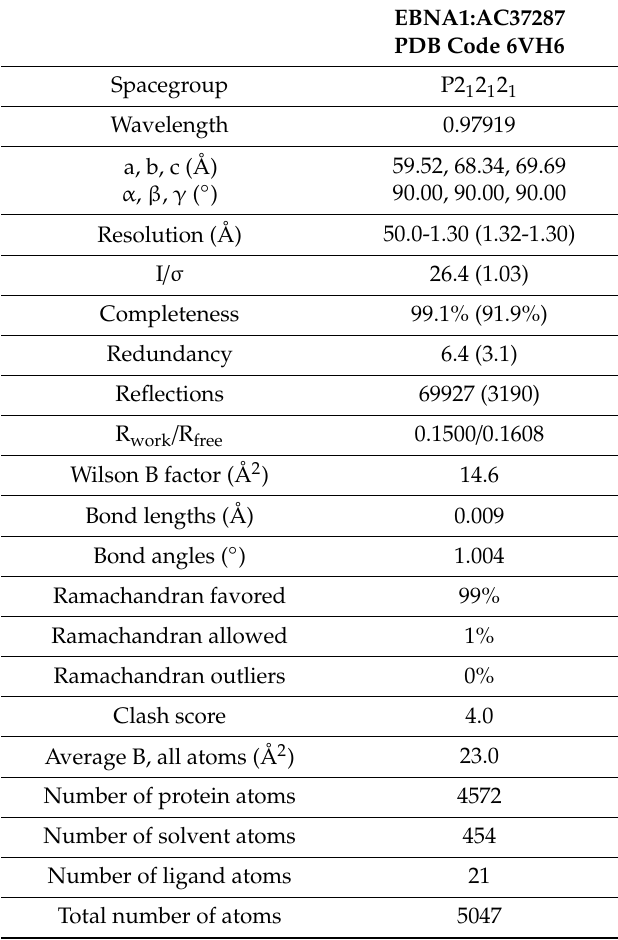
Table 1. Data collection and refinement statistics of the EBNA1:AC37287 cocrystal structure.